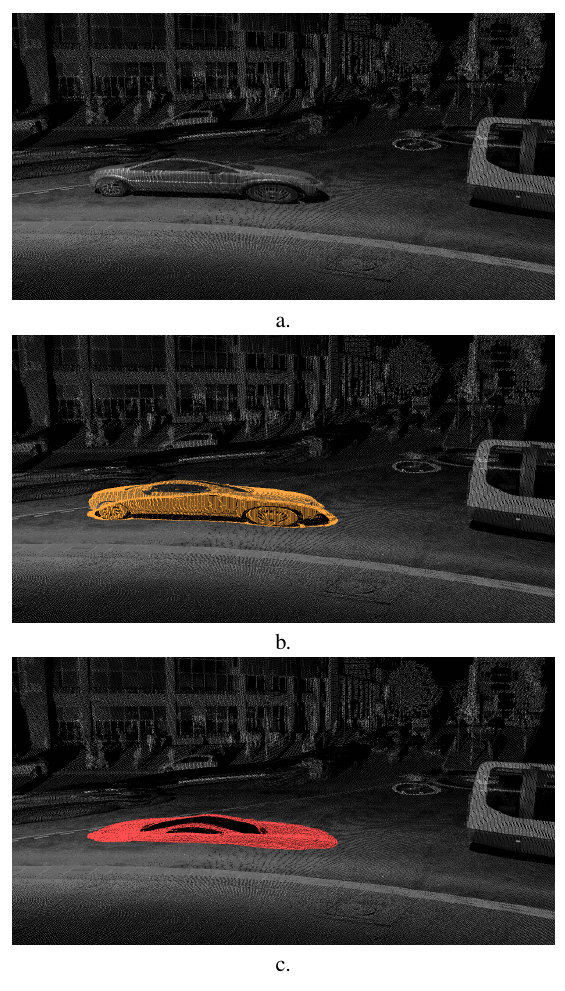
Figure 10. Result of the disocclusion on a car in a dense point cloud. (a) is the original point cloud colorized with the reflectance, (b) is the segmentation of the car highlighted in orange, (c) is the result of the disocclusion.